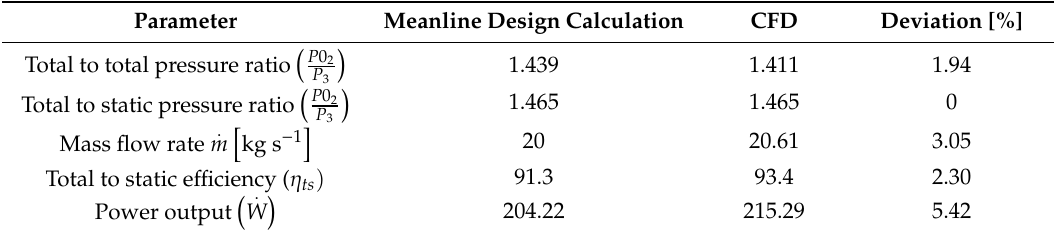
Table 5. Comparison of meanline and CFD results for the computed optimized